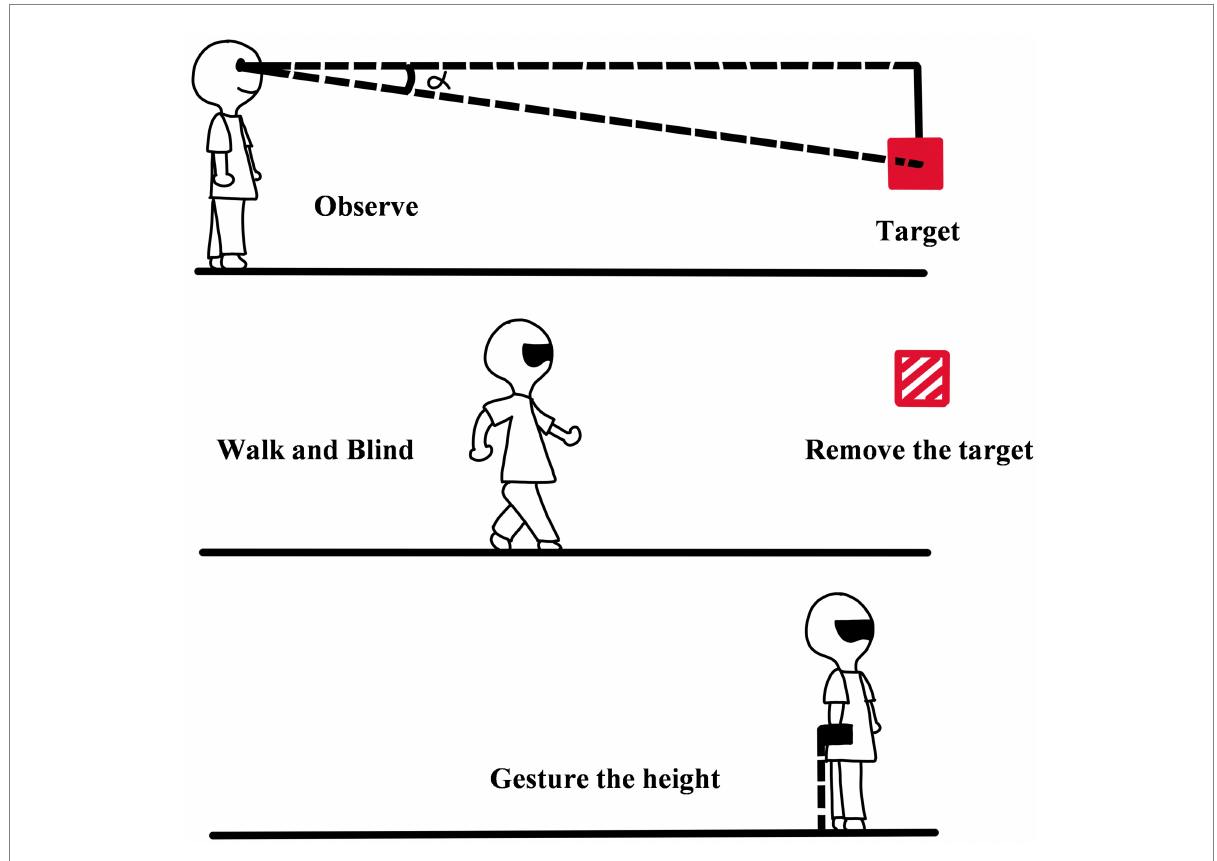
FIGURE 5 The diagram of blind walking